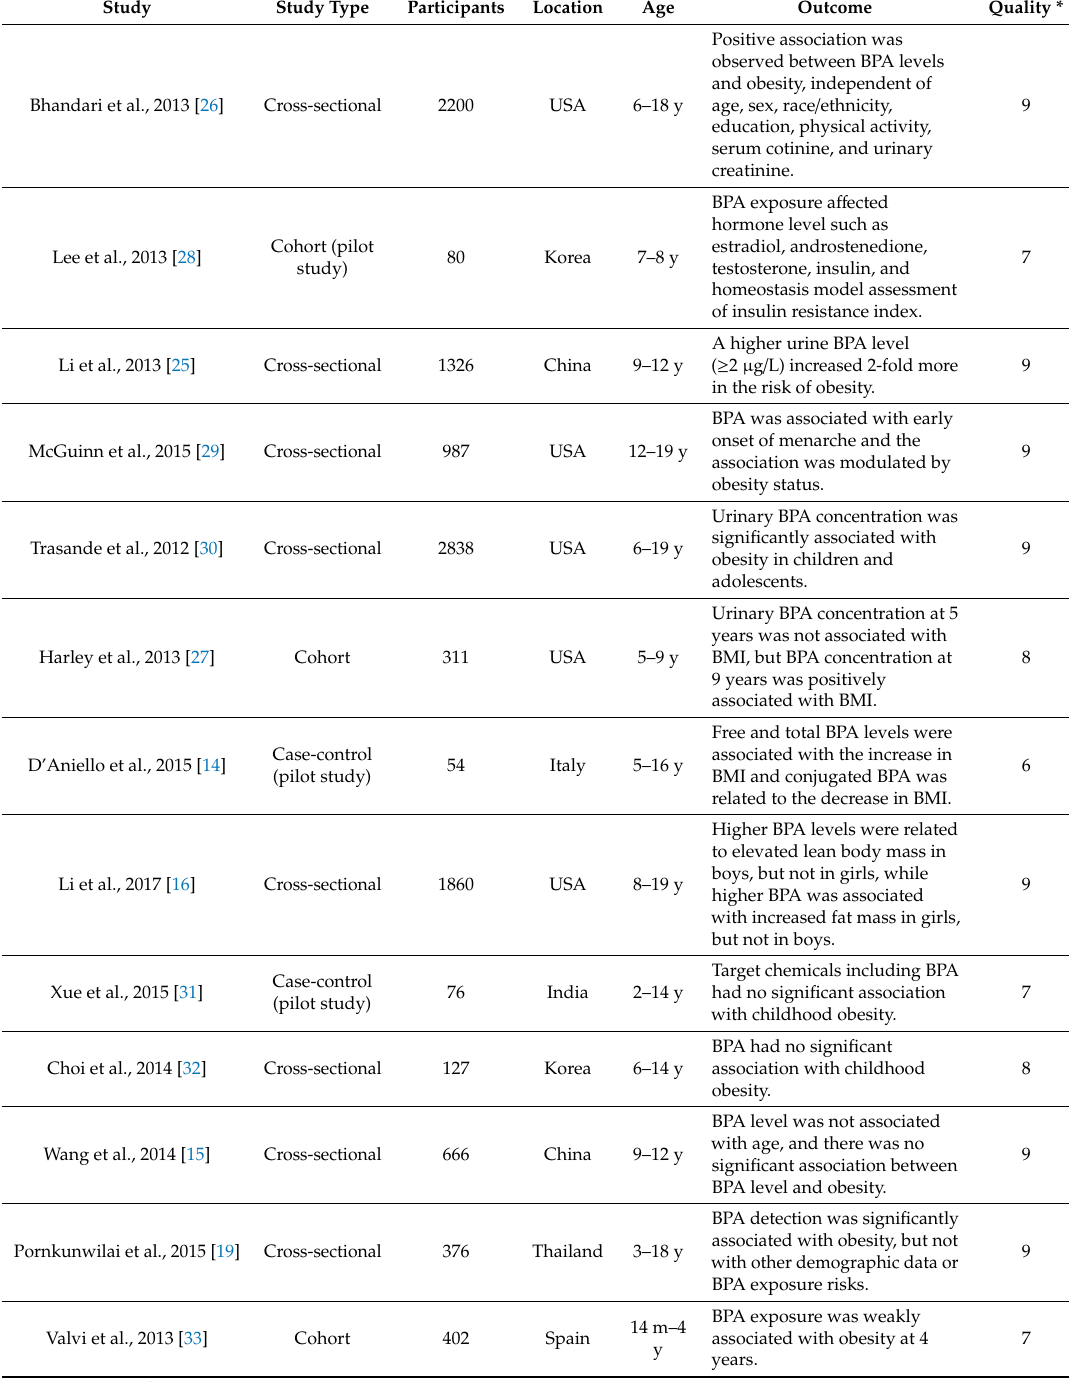
Table 1. Characteristics of the 13 included studies on the association between BPA exposure and childhood